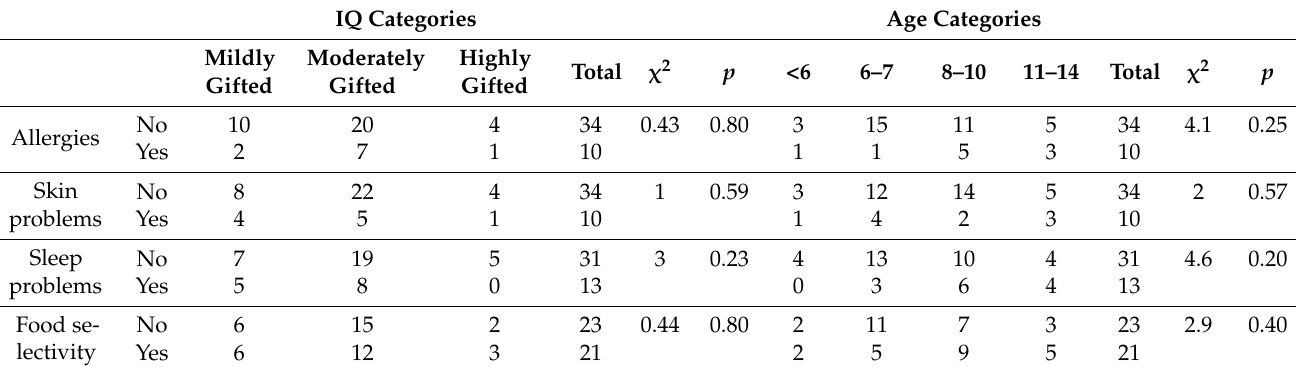
Table 3. Health-related